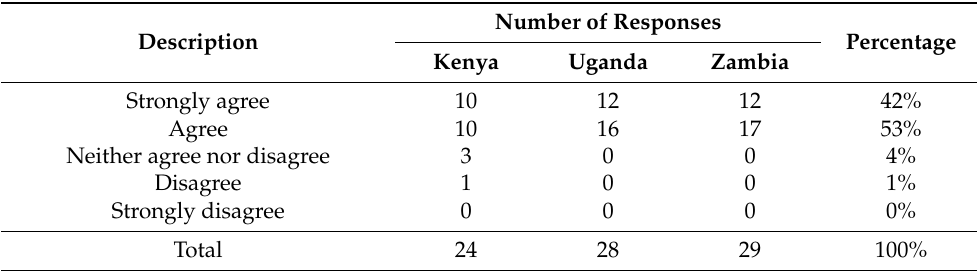
Table 2. Responses on whether the STDM facilitates tenure security.